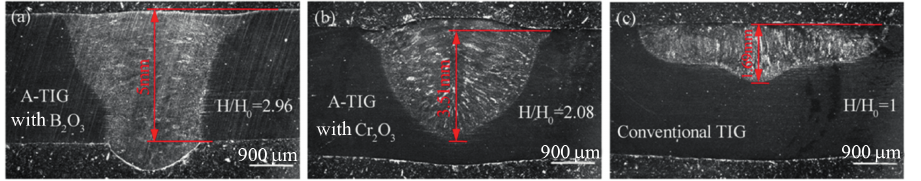
Figure 2: Macroscopic morphology of the weld beads: (a) A-TIG with B 2 O 3 ; (b) A-TIG with Cr 2 O 3 ; and (c) Conventional TIG.